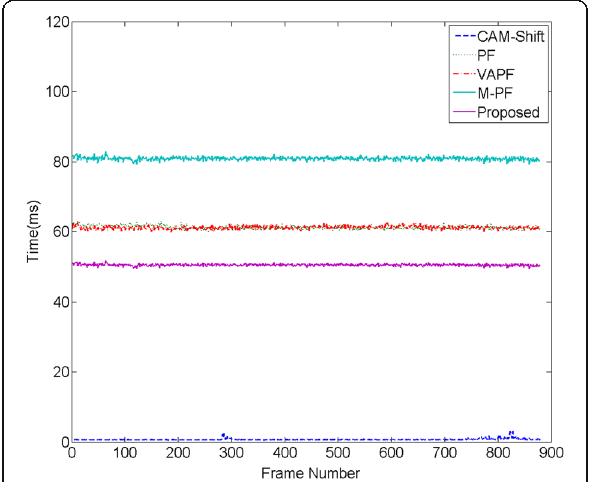
Fig. 26 Resulting of time consuming of video “ basketball_1 ” with the particle number N =